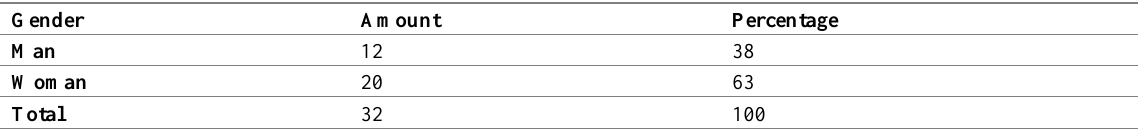
Table 1: Gender of Respondents